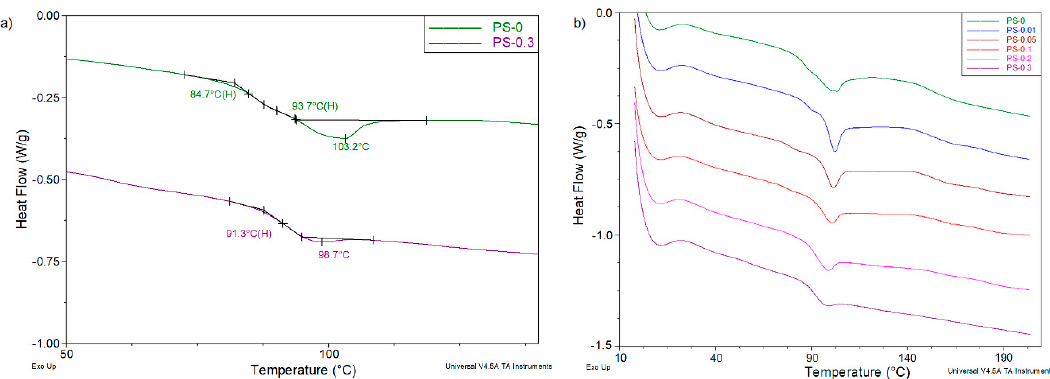
Figure 6. DSC curves registered at the heating mode in the temperature range of the glass transition: ( a ) pure PS and PS-0.3 samples; ( b ) all obtained samples. Table 2. Values of characteristic temperatures of glass transition T g1 ,T g2 and enthalpy relaxation peak parameters, T ER and ∆ H ER , respectively, determined on the basis of DSC measurements. Sample T g1 , °C T g2 , °C T ER , °C ∆ H ER , J/g